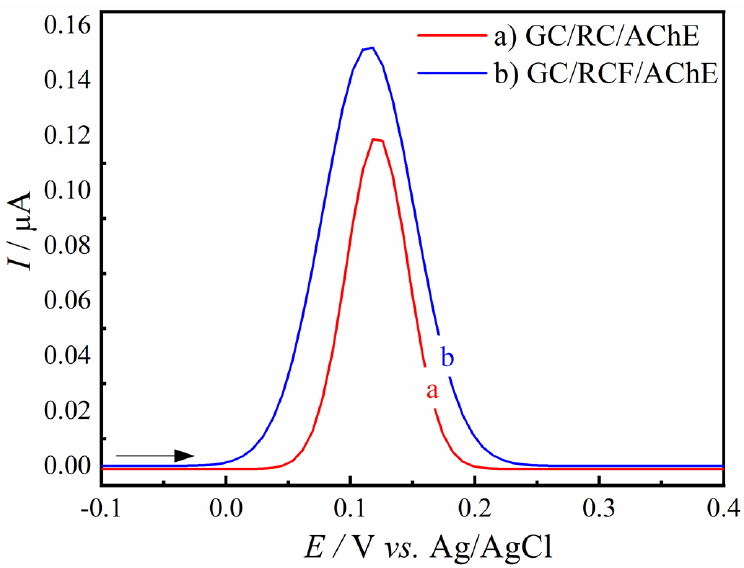
Figure 6. DPV responses of GC/RC/AChE (a) and GC/RCF/AChE (b) biosensors in the presence of − 1 of AChI substrate in a 0.2 mol L − 1 PBS solution pH 50.0 µmol L − 1 of AChI substrate in a 0.2 mol L − 1 PBS solution pH 7.5. 50.0 µ mol L